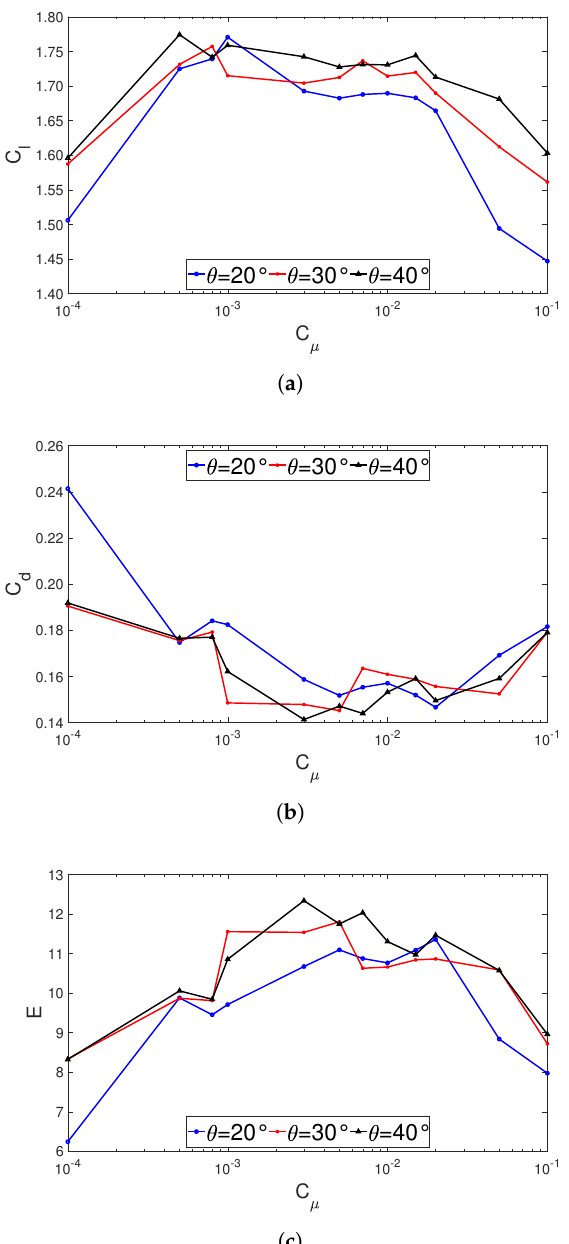
Figure 9. Aerodynamic coefficients comparison for the different C µ and θ studied. ( a ) Lift coefficient comparison for the different C µ and θ studied. ( b ) Drag coefficient comparison for the different C µ and θ studied. ( c ) Aerodynamic efficiency comparison for the different C µ and θ